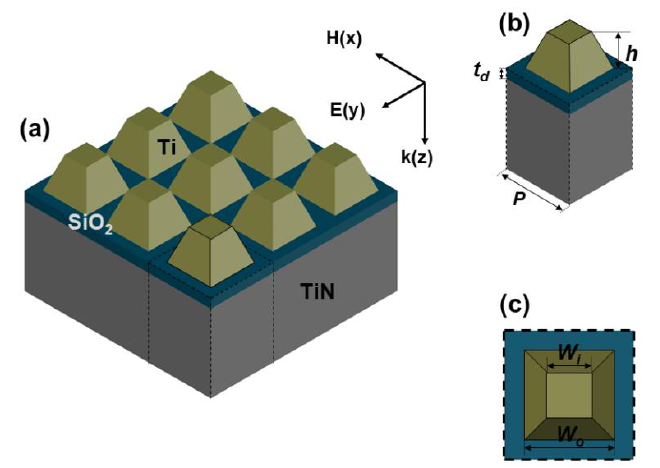
Figure 1. Sketch of the proposed truncated-pyramid metamaterial absorber (MA) structure. ( a ) 3D view of MA structure. ( b ) Magnified 3D view unit cell of MA. ( c ) Top view of tapered resonator shape.